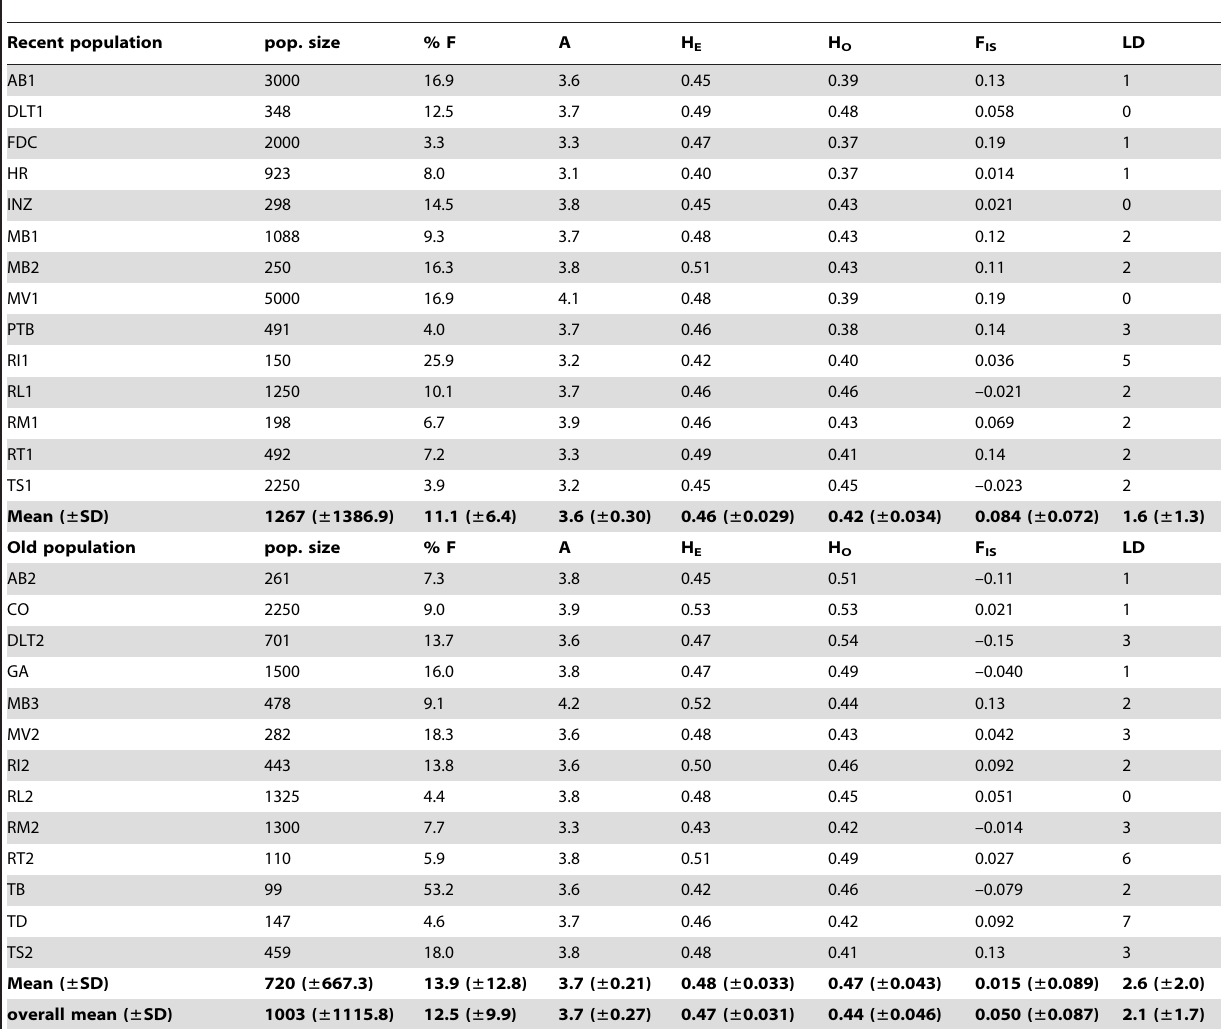
Table 1. Population characteristics of all sampled Origanum vulgare populations for recent and old populations separately.